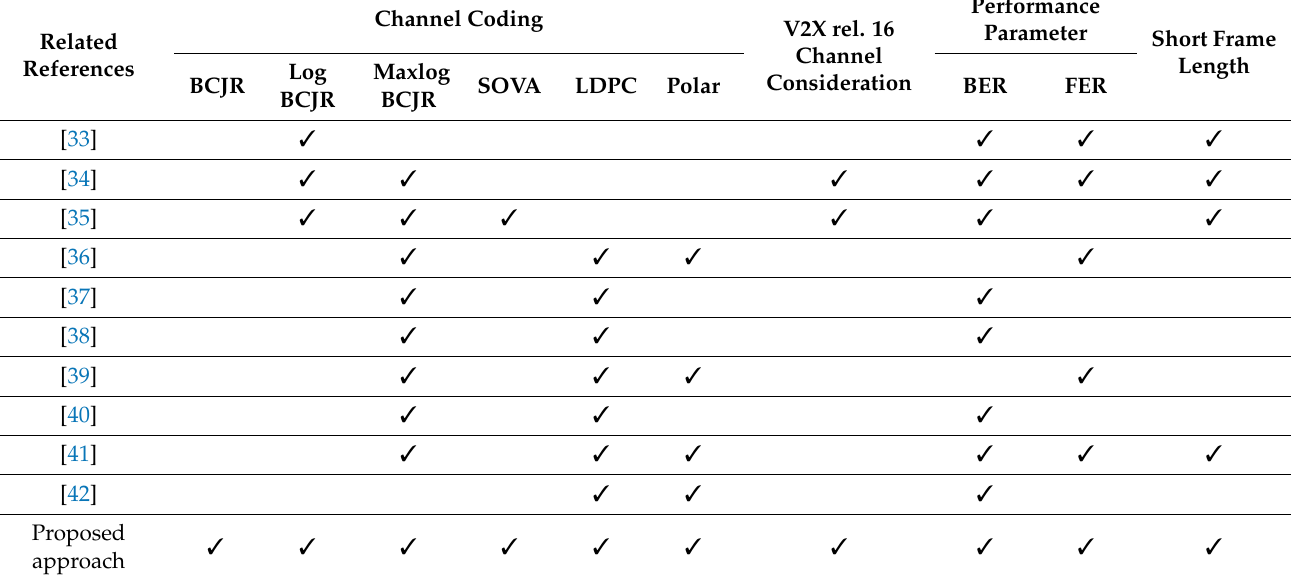
Table 13. Comparison of our proposed approach with published literature. The symbol (cid:51) defines that the field has been implemented and examined in the corresponding